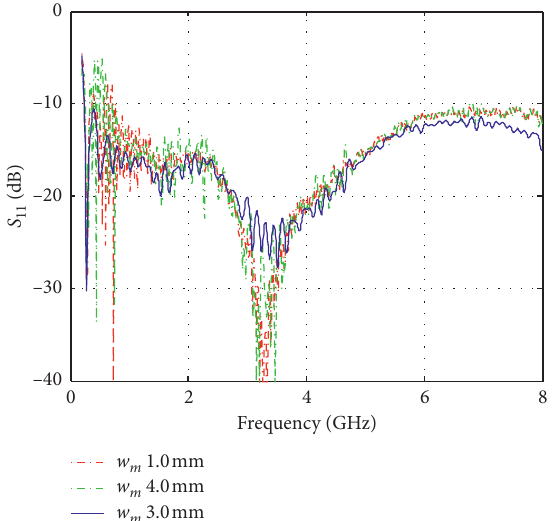
Figure 10: Simulated reflection coefficient of antennas with different w